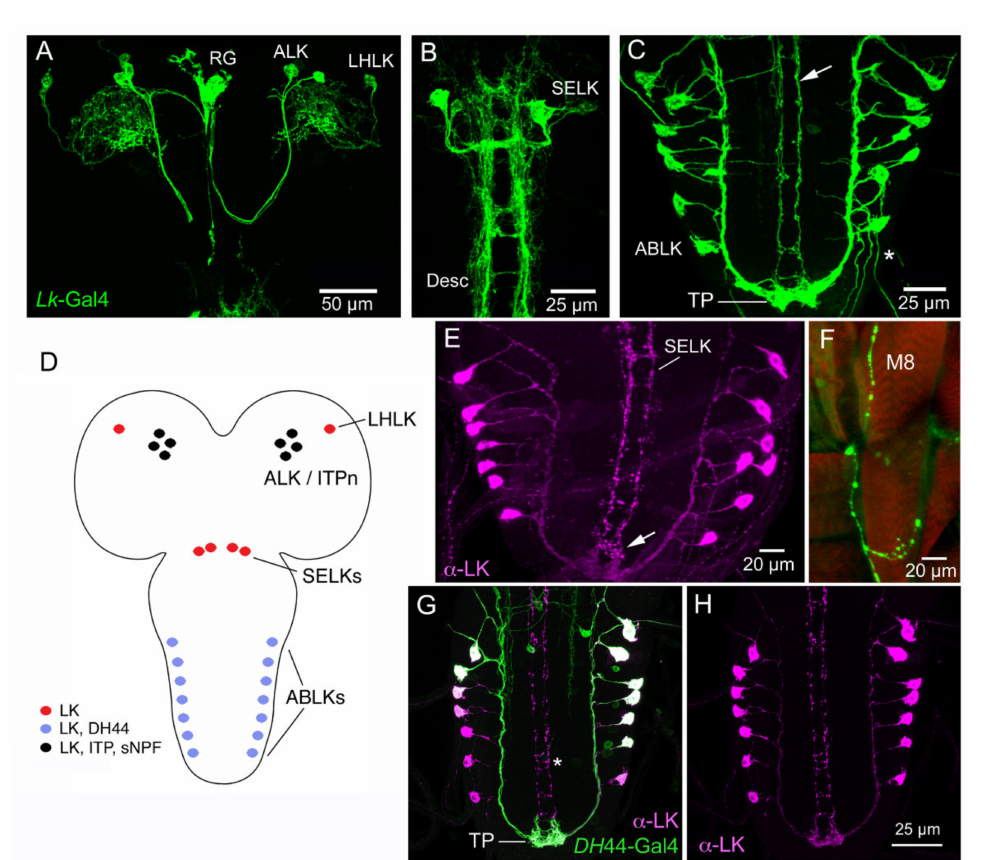
Figure 1. Expression of leucokinin (LK) and other peptides in the CNS of larval Drosophila . ( A ) Larval brain with Lk -Gal4 expression in LHLK (lateral horn LK) and ALK (anterior LK) neurons. The ALKs have axon terminations in the ring gland (RG). ( B ) SELK (subesophageal LK) neurons of the larval brain/ventral nerve cord with their descending axons (Desc). ( C ) The abdominal leucokinin neurons (ABLKs) and axons of SELKs (arrow). Note the terminal plexus neuropil (TP) with axonal processes of both ABLKs and SELKs. ( D ) Schematic of the LK-expressing cell bodies. Colors indicate the different peptides expressed in the neurons. ( E ) LK immunolabeling of ABLKs and SELK axons. The arrow indicates the terminal plexus. ( F ) Axon termination of an ABLK on body wall muscle 8 (M8). ( G , H ) The ABLKs, but not SELKs (asterisk), co-express LK and diuretic hormone 44 (DH44). Images in Figure 1 are modified and rearranged from [37,96], with permission from